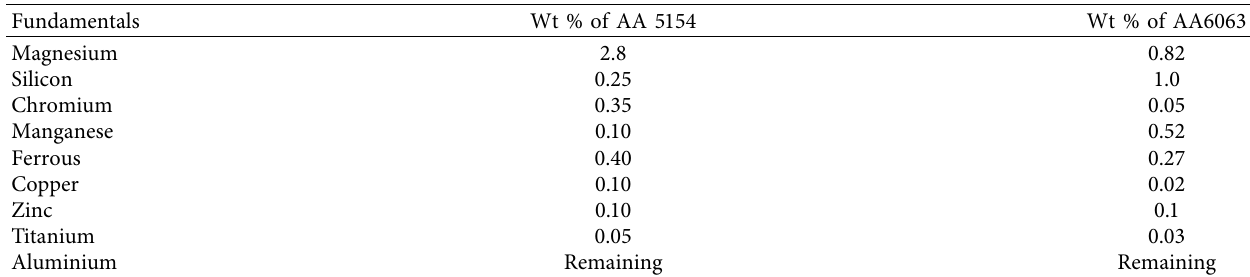
Figure 1: Schematic illustration of friction stir spot welding. Table 1: Chemical properties of AA 5154 and AA6063.